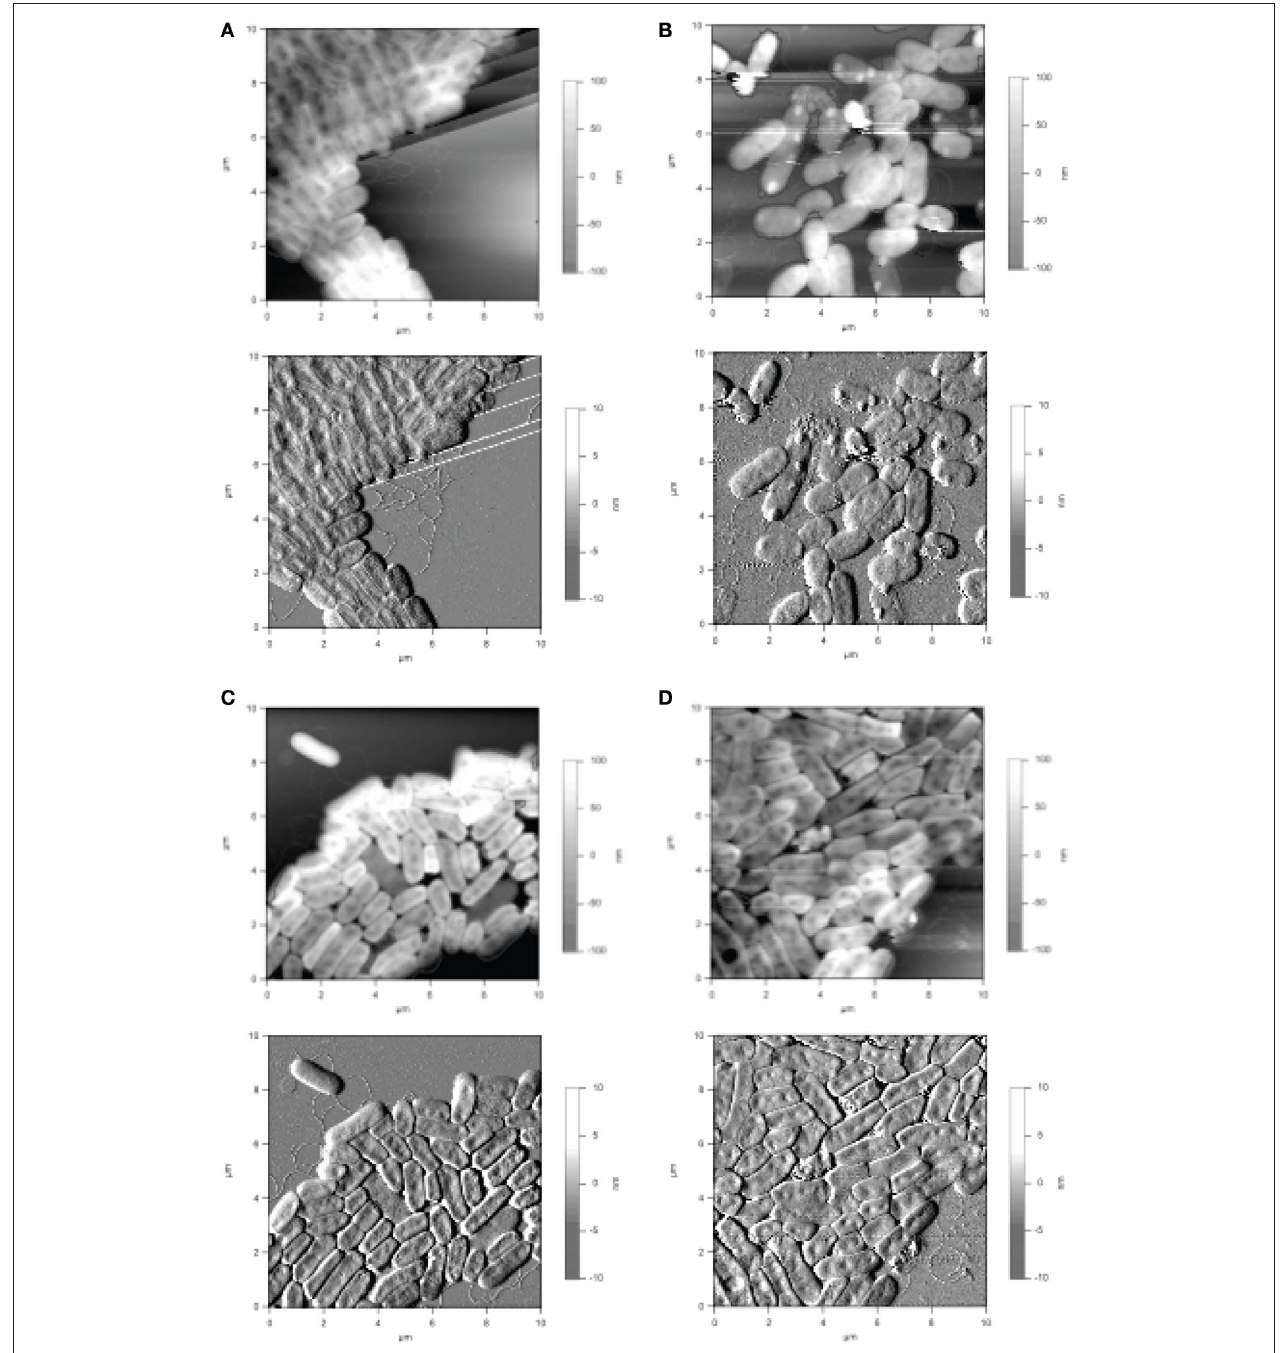
FIgure 6 | Images obtained from Atomic Force Microscopy analyses of P. aeruginosa cells collected in contact mode in air. (A) Strain PAO1; (B) migA mutant; (C) wapR mutant; (D) rmlC mutant. Height images (top panels) are shown with enclosed areas for roughness calculations. Deflection images (bottom panels) reveal more details in cell morphology. The straight lines in (A) are steps in the mica substratum. Reproduced from Lau et al. (2009b), with permission from Copyright Clearance